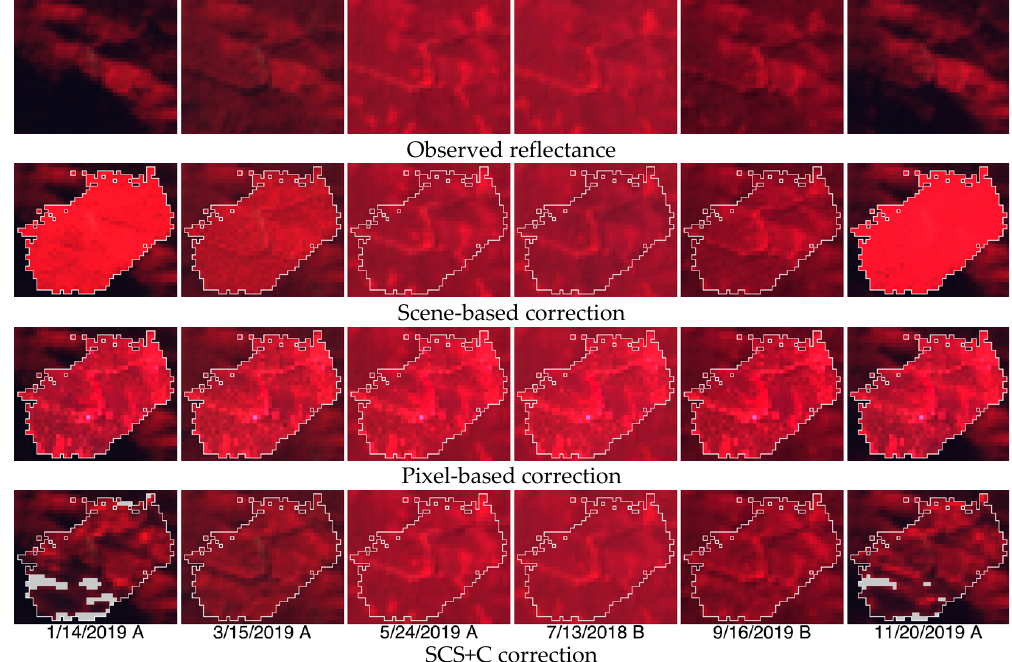
Figure 7. Example of a false-color image of shadow-corrected reflectance: observed reflectance, and scene-based, pixel-based, and SCS+C correction. The reflectance from 0.0 to 0.4 is scaled from 0 to 250 in the digital image. The corrected area resides inside the white frame; the outside is the observed reflectance.